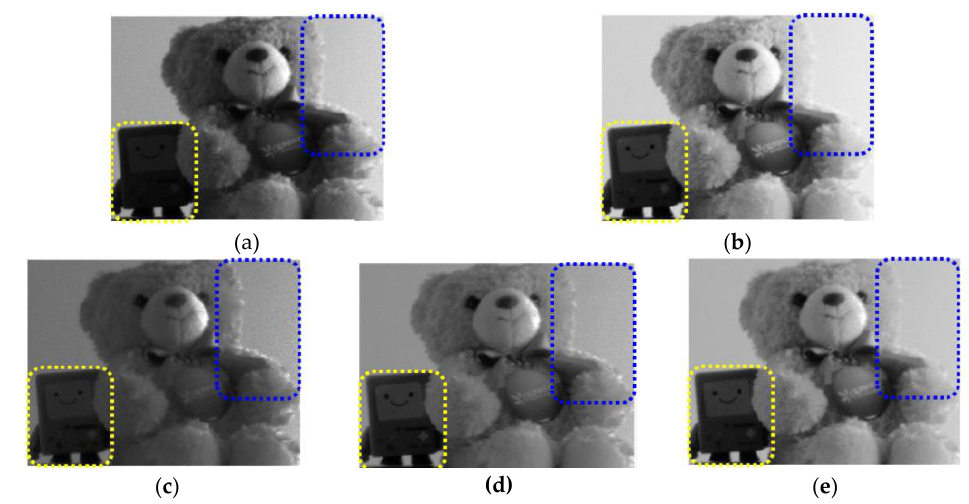
Figure 7. Evaluated images @ 550 lux. ( a ) Normal image with linear mode; ( b ) gamma-corrected image; bi-directional gamma-corrected images for ( c ) ¼ pt., ( d ) ½ pt., and ( e ) ¾ pt.